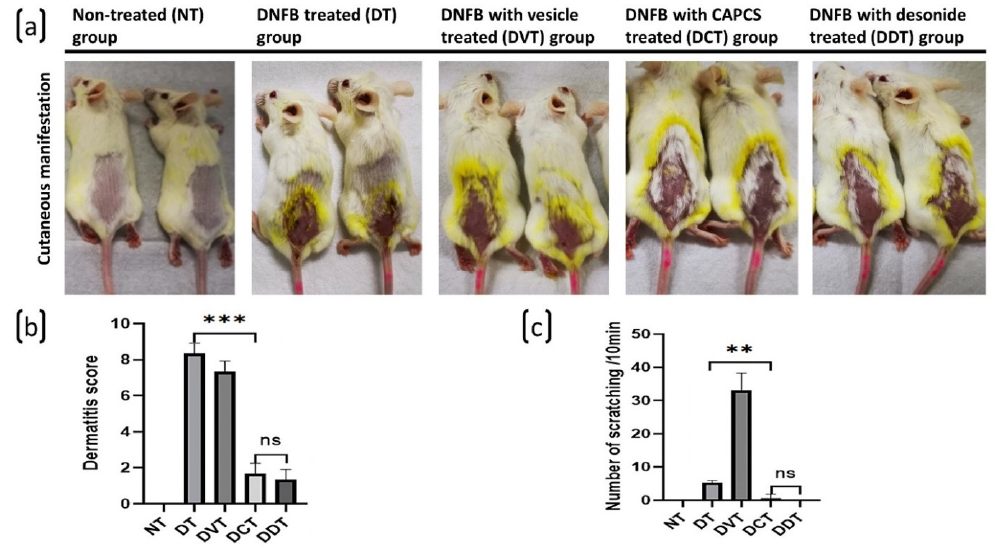
Figure 2. Cutaneous manifestations of DNFB-induced AD-like symptom, dermatitis score, and scratching behavior in BALB/c mice. ( a ) Cutaneous manifestations of mice in each group. No skin lesions of AD-like symptom were seen in the NT group, obvious erythema, oozing, edema, excori- ation, and crust were observed in DT and DVT groups, and noticeable erythema and dryness, mild edema and crust, without obvious oozing, excoriation, or lichenification were found in the DCT and DDT groups. ( b ) The final dermatitis scores were 0 in the NT group, significantly lower in the DCT and DDT groups than the DT and DVT groups, and the scores were similar between the DCT and DDT groups. ( c ) Scratching behavior was observed every 3 days before and after the successful modeling, and the scratching times of mice in 10 min were recorded and counted by video camera. The scratching behavior of mice was obviously reduced in the DCT and DDT groups, and there were no significant differences observed between these two groups (data are presented as the mean ± S.E.M; ns: no significance, ** p < 0.01 and *** p < 0.001). 2.2. CAPCS Suppresses Infiltration of Inflammatory Cells and Inhibits Expression of Inflammatory Cytokines in DNFB-Induced AD-Like Skin Lesions of BALB/c Mice The expression of inflammatory cytokines, including IFN-γ, IL-4, IL-5, IL-13, IL-31, IL-17, and IL-22, was significantly increased in DNFB-induced AD-like dorsal skin lesions of the DT, DVT, DCT, and DDT groups, in comparison to normal dorsal skin in the NT group. Furthermore, cytokine expression levels were significantly decreased in the DCT and DDT groups, in comparison to the DT and DVT groups ( p < 0.05) (Figure 3). There were no significant differences observed between the DCT and DDT groups and the DT and DVT groups (Figure 1).